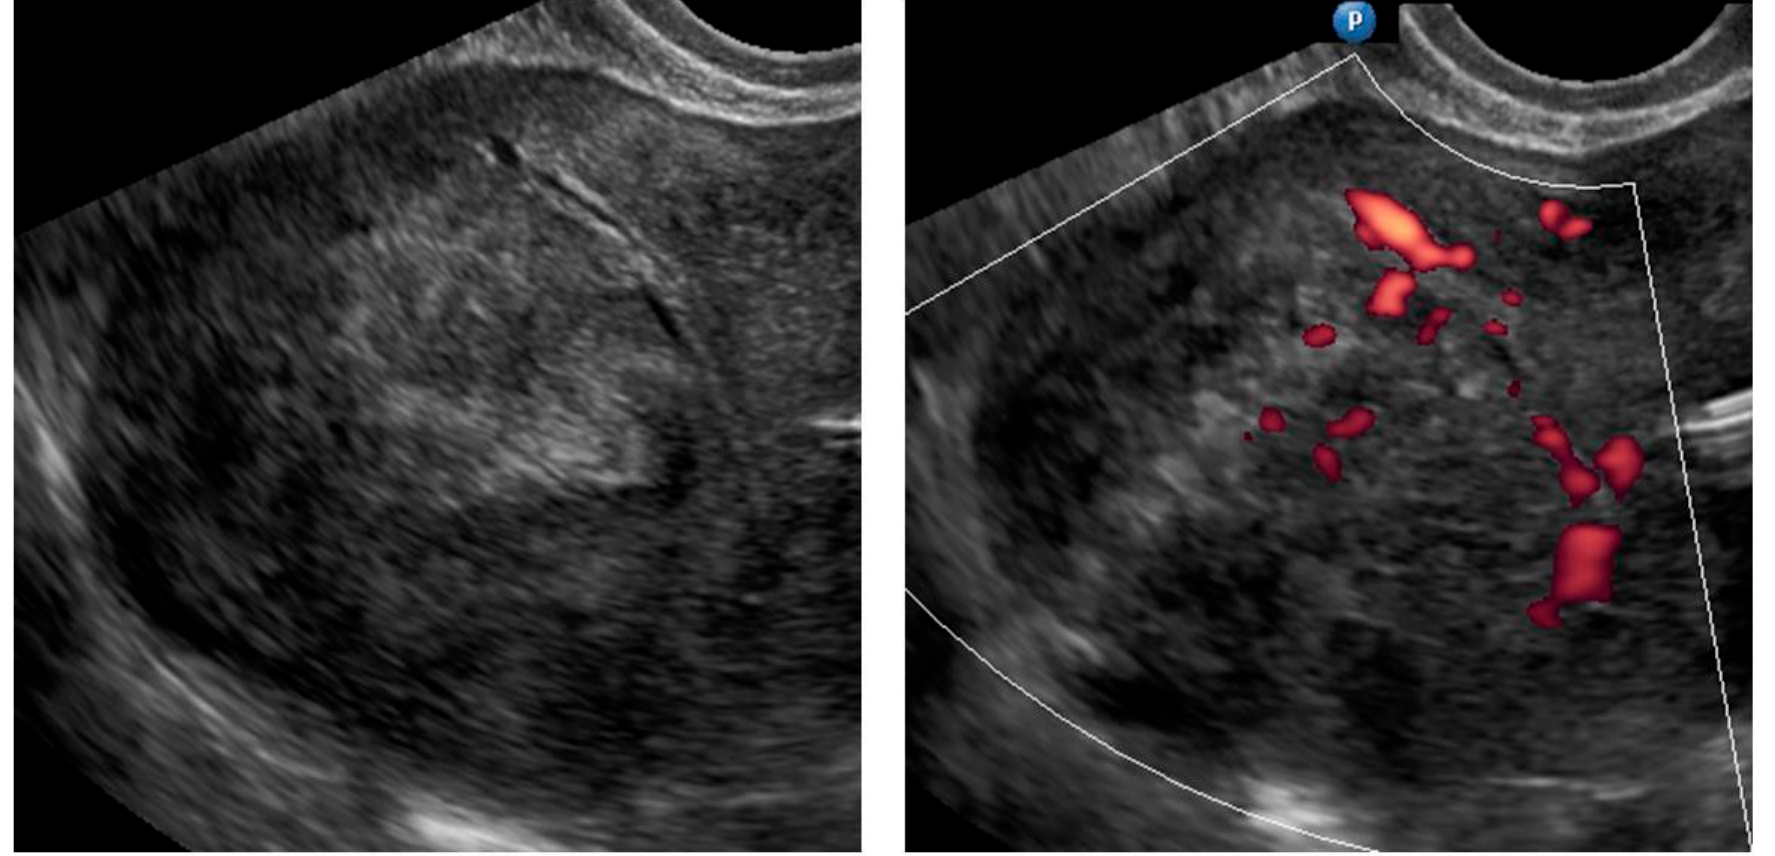
Figure A1. Transvaginal ultrasonogram of the uterine lesion (typical myoma) in the myometrium in the uterine doom, B mode and Doppler. Histology: leiomyoma, cellular variant.